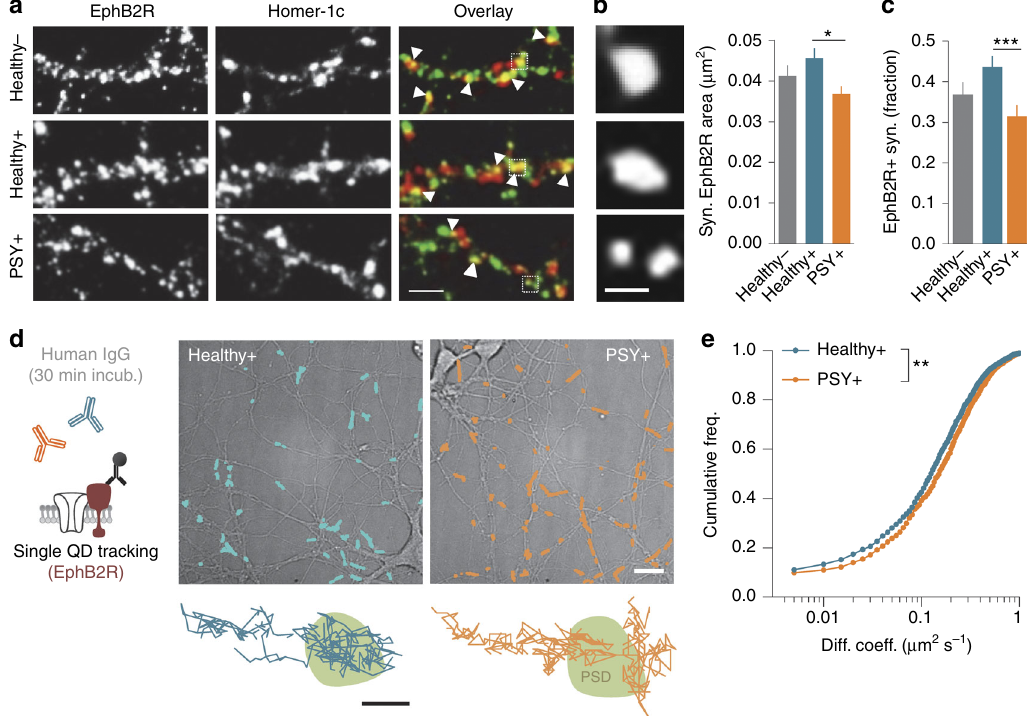
Fig. 6 Synaptic EphB2R diffusion and distribution are speci fi cally altered by PSY + NMDAR-Ab. a Immunostaining of surface EphB2R in hippocampal neurons (12 div) exposed to puri fi ed IgG from Healthy − , Healthy +, or PSY + samples for 12 h. One out of one Healthy − , three out of three Healthy +, and four out of nine PSY + samples were used and pooled for comparisons. Synaptic EphB2R were determined as overlapping clusters with the synaptic marker Homer-1c (white arrowheads). Scale bar, 2 µ m. b Left panel: synaptic EphB2R clusters after a 12 h exposure to Healthy − , Healthy +, or PSY + puri fi ed IgG. Scale bar, 500 nm. Right panel: mean ± SEM of synaptic EphB2R clusters area exposed to Healthy − ( n = 24 neurons), Healthy + ( n = 49), or PSY + ( n = 40) puri fi ed IgG. Exposure to PSY + NMDAR-Ab for 12 h reduces the area of synaptic EphB2R clusters (* P = 0.0359, Kruskal – Wallis test followed by Dunn ’ s multiple comparison test). c Fraction of EphB2R-positive synapses after incubation with Healthy − ( n = 25 neurons), Healthy + ( n = 49), or PSY + ( n = 41) puri fi ed IgG. PSY + NMDAR-Ab affect the proportion of synaptic EphB2R (*** P < 0.001, Kruskal – Wallis test followed by Dunn ’ s multiple comparison test). d Surface live tracking of endogenous EphB2R in hippocampal neurons (15 div) exposed to Healthy + or PSY + NMDAR-Ab for 30 min. Scale bar, 20 µ m. Bottom panel: Representative EphB2R single trajectories within PSD areas. Scale bar, 500 nm. e Cumulative distributions of the instantaneous diffusion coef fi cient of synaptic EphB2R in the presence of Healthy+ ( n = 1,432 trajectories, N = 33 neurons) or PSY + NMDAR-Ab ( n = 1104, N = 39). The distribution is shifted toward the right after exposure to PSY + NMDAR-Ab (** P < 0.01, Kolmogorov – Smirnov